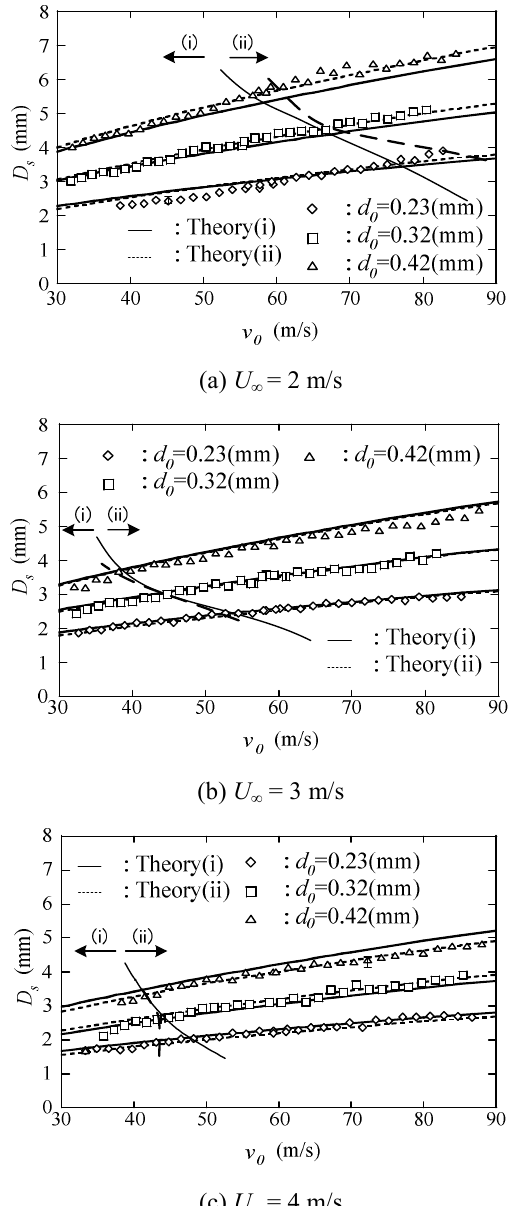
Fig. 10 Comparison of the separated bubble diameters between theory and experiment